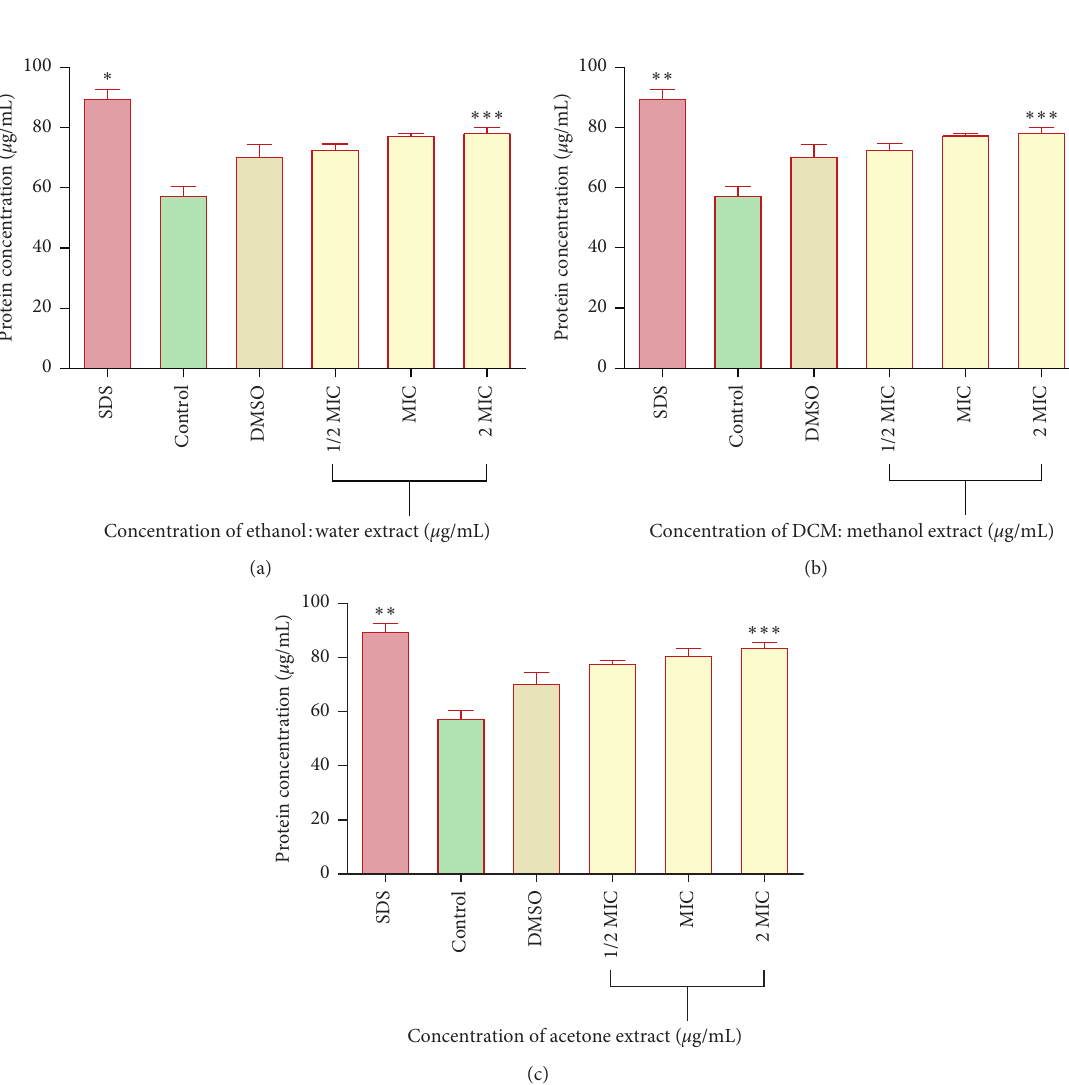
Table 1: Effects of extracts from P. americana on the cell viability of K. pneumoniae , S. epidermidis , C. albicans , and C. tropicalis . Extract